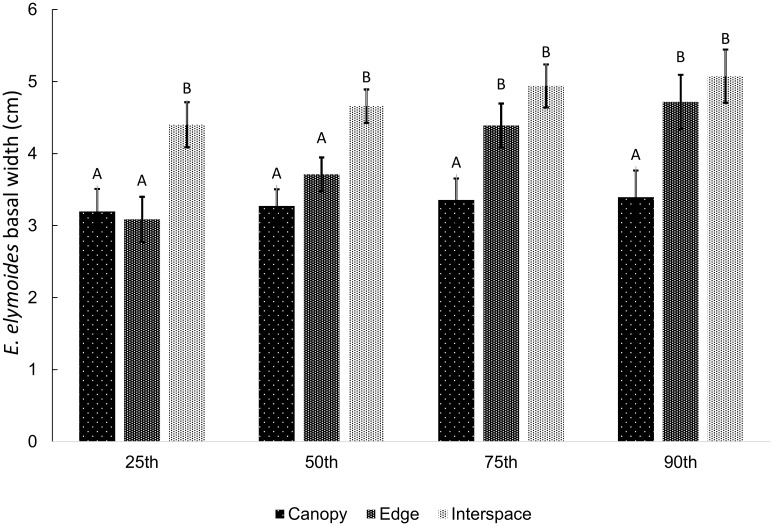
Least square means for E. elymoides basal width (cm) at 25th, 50th, 75th, and 90th percentile of rainfall.Error bars represent standard error of the mean; different letters denote means that differ significantly from one another within each percentile of rainfall.